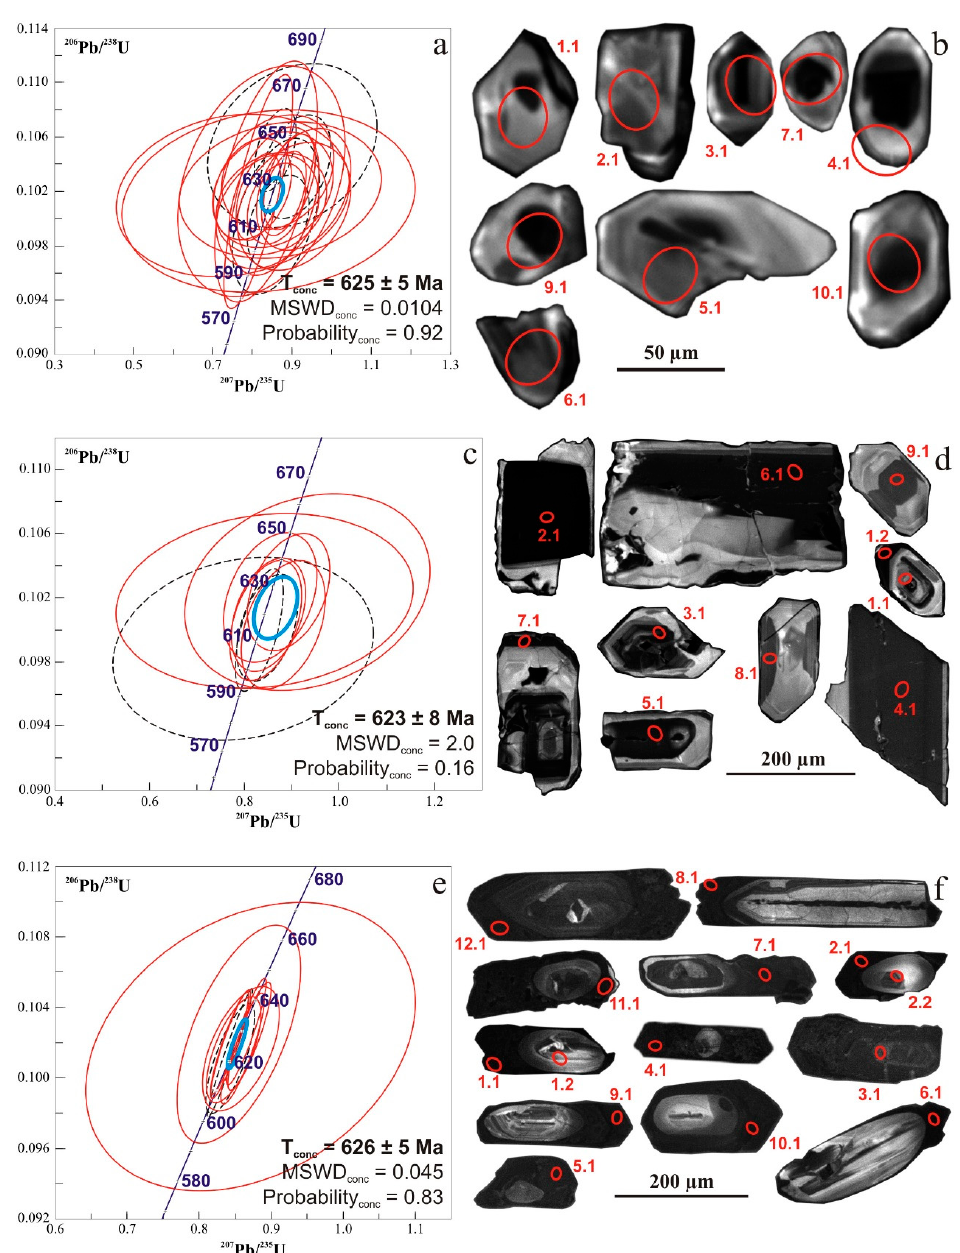
Figure 9. Concordia diagrams and CL images for zircons from picrodolerite sample YR16-4 ( a,b ), quartz diorite sample A09-11 ( c,d ) and leucocratic granite sample M08-3 ( e,f ). Red circles in the zircon CL images indicate the U/Pb isotopic analysis spots. The blue ellipse is the weighted-mean error